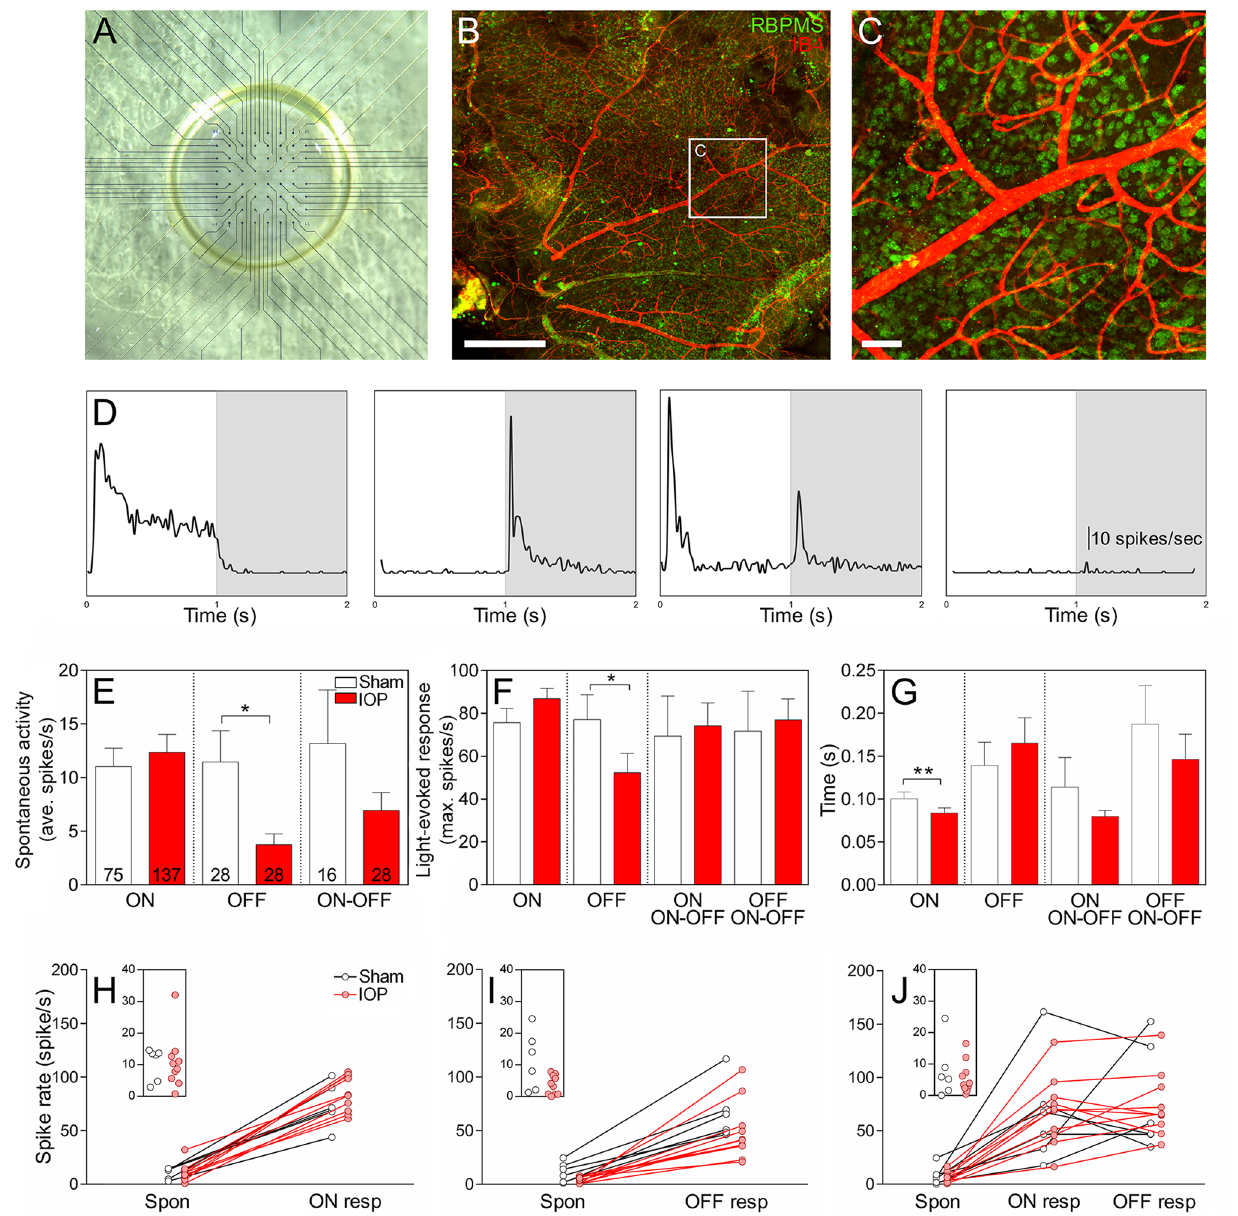
Figure 2. PMEA recordings of isolated WT mice retinae demonstrate a reduction in OFF-RGC responses and a reduction in ON-RGC latency following acute IOP elevation. The pMEA consists of a grid of electrodes, in which the retina rests RGC-side down with the aid of a vacuum pump that applies suction from below ( A ). Immunohistochemical staining after recording revealed little damage as the RGCs (RBPMS, green) and blood vessels (IB4, red) appeared intact (( B ) scale bar 500 µm, magnified inset ( C ) scale bar 50 µm). ( D ) Representative peri-stimulus time histograms of RGC cell types in response to light on (white shading) or light off (grey shading). From the left to right of the panel, examples of an ON, OFF, ON–OFF and no-full-field- response cell are presented. ( E – G ) OFF-RGCs show a reduction in average spontaneous spike rate ( E ) and maximum spike rate ( F ) following elevated IOP (red bars) relative to sham eyes (clear bars). ON-RGCs show a reduction in latency to peak following elevated IOP ( G ). Numbers indicate the number of cells recorded from n = 6–10 animals. The spontaneous activity and light-elicited responses were averaged per retina and are presented for sham (black) and elevated IOP (red) for ON ( H ), OFF ( I ) and ON–OFF ( J ) RGCs. Insets show the spontaneous rate of cells from sham and elevated IOP eyes. * p < 0.05, ** p < 0.01; Mann–Whitney test (sham vs